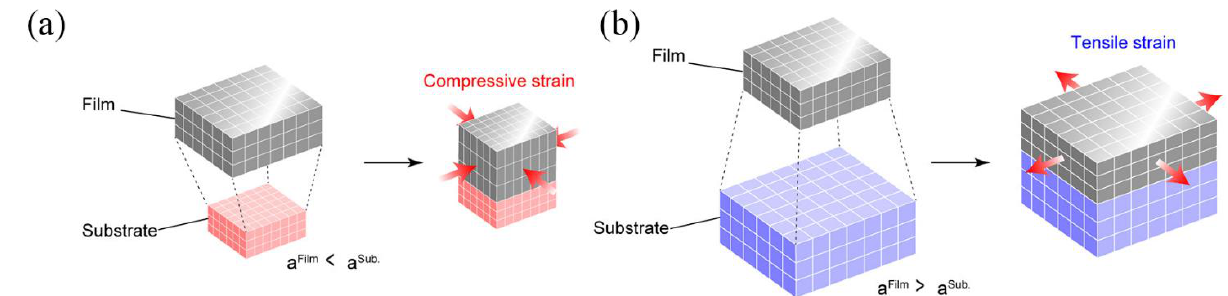
Figure 2. ( a ) a Film < a Sub ; compressive strain. ( b ) a Film > a Sub ; tensile strain. Adapted with